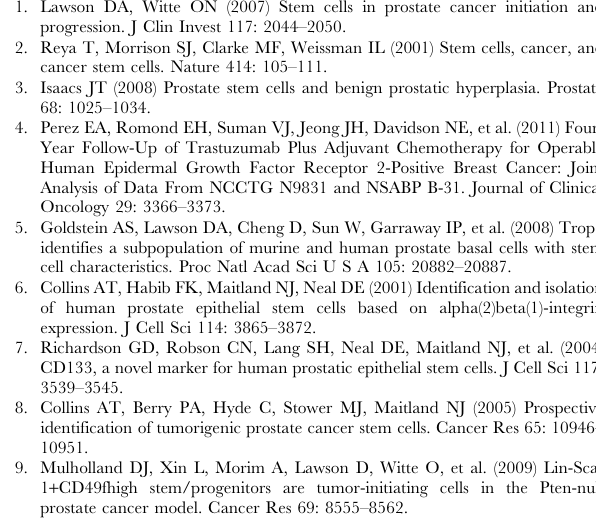
Figure S4 Flow cytometric purity assessment of positive and negative cell fractions following immunomagnetic separation of a mixture of Caco-2 and PC3 cells using CD133 (AC133) antibody (representative images of n = 3). A. Flow cytometric analysis of unsorted Caco-2 and PC3 cells. Almost all Caco-2 cells express CD133 ( . 97%), in contrast to PC3 cells which were CD133 2 by phenotype. B. The two cell lines were mixed at a ratio of 2 PC3 : 1 Caco-2 and sorted by MACS to obtain positive and negative fractions. Flow cytometric purities of CD133 + and CD133 2 fractions post-selection were 95.4 6 3.21% and 81.7 6 5.40%, respectively (n= 3). n = 20,000 live cells for all analyses. FS= for- ward scatter. MACS= magnetic cell separation (TIF) Figure S5 A. Human prostate epithelial cells can be cultured without collagen coating (a representative image of an epithelial colony is shown using the same protocol described in the methods, but without collagen pre-coating). B. CD49f is an integrin with potential to bind collagen [54]. To determine whether collagen- coating was responsible for the enhanced colony forming capacity of CD49f + cells, the colony-forming assay was repeated as described in Figure 3, without collagen pre-coating. In the absence of collagen coating, our results again showed the highest colony-forming cell recovery in CD49f + cells. Table S1 Table indicating the sources of prostate tissue, patient age, and PSA value for each benign tissue. All samples listed were histologically confirmed to have benign histology. HoLEP =Hol- mium laser enucleation of